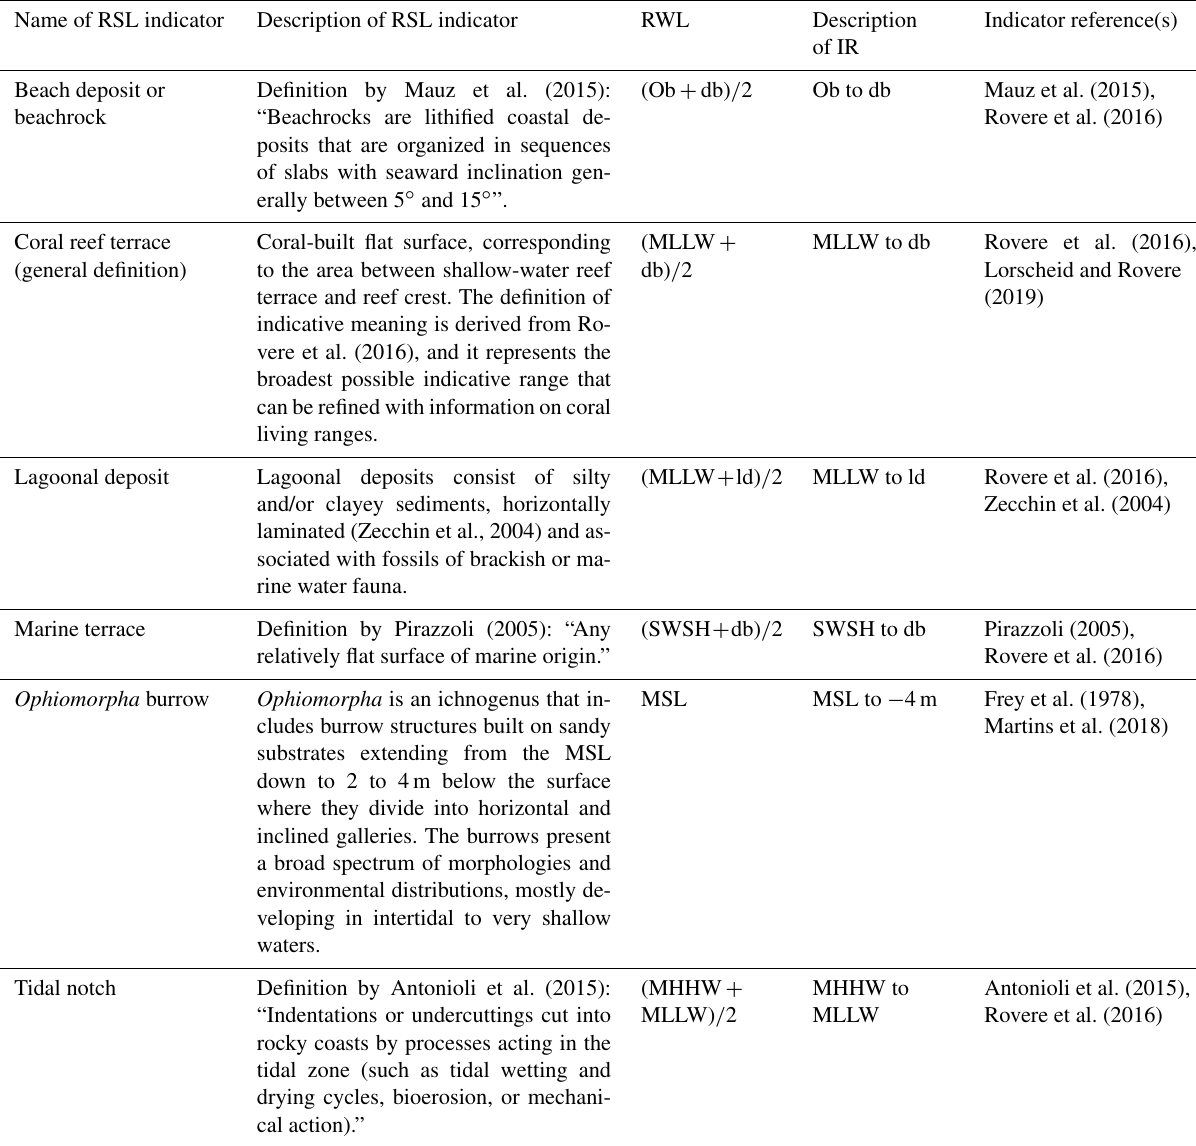
Table 1. Sea-level indicators in the study area, with reference water level (RWL) and indicative range (IR) quantifications. db denotes breaking depth; ld denotes lagoonal depth; MHHW denotes mean higher high water; MLLW denotes mean lower low water; MSL denotes mean sea level; Ob denotes ordinary berm; SWSH denotes storm wave swash